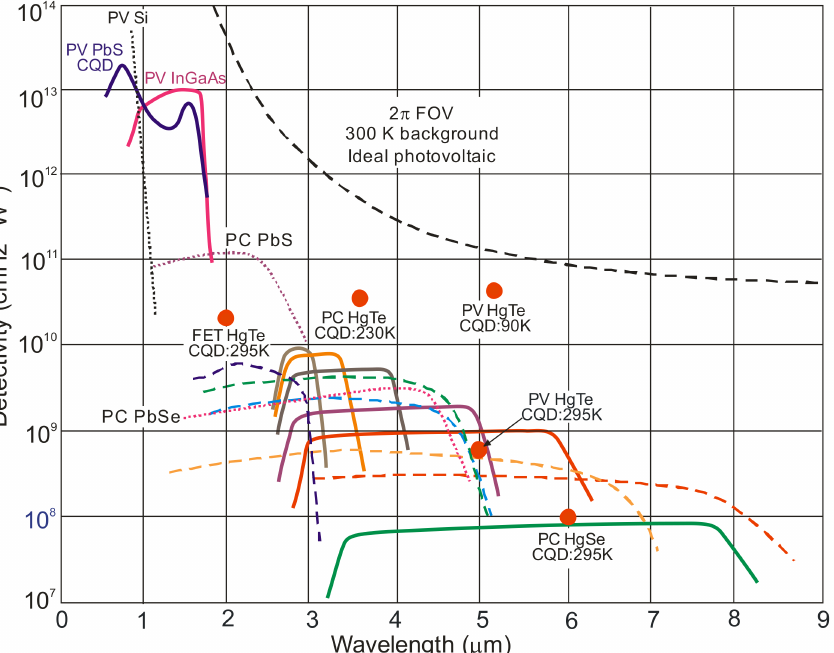
Figure 20. Room-temperature spectral detectivity curves of the commercially available photode- tectors [PV Si and InGaAs, PC PbS and PbSe, HgCdTe photodiodes (solid lines reference [33])]. The experimental data for different types of CQD photodetectors are marked by dot points (refer- ence [49,70,78–81]). Also, spectral detectivity of new emerging T2SL IB QCIPs are included [38]. PC—Photoconductor,